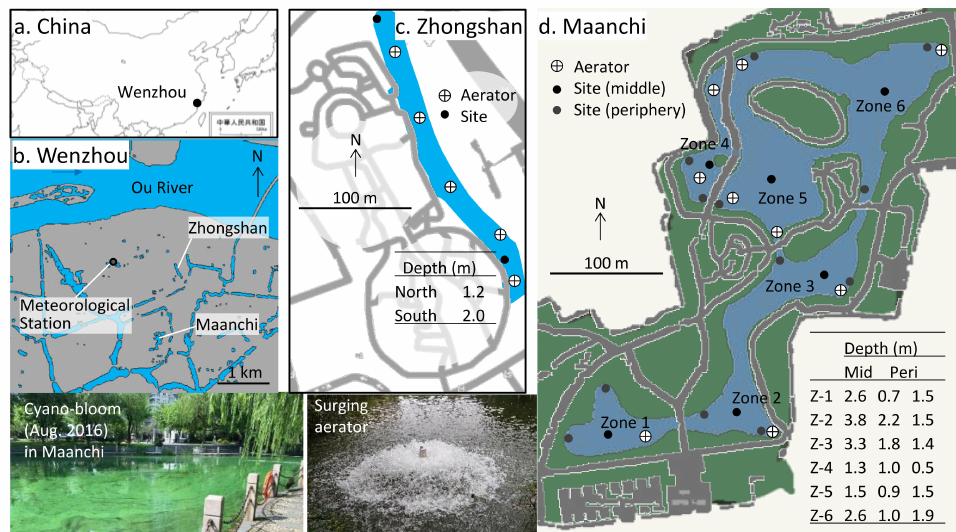
Figure 1. Map of China ( a ), Wenzhou ( b ), Zhongshan Park ( c ), and Maanchi Park ( d ), and photos of cyanobacterial bloom and surging aerator in Maanchi Park. The location of monitoring sites and aerators are shown on the